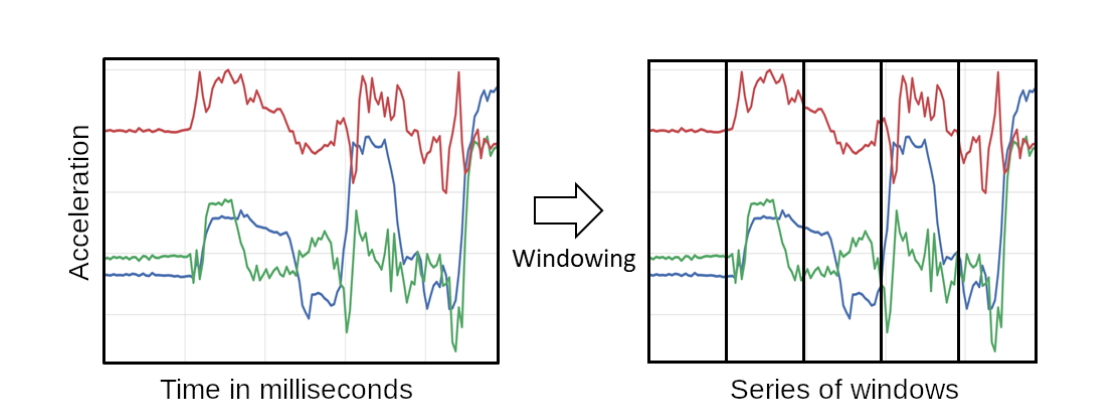
Figure 6. Windowing of inertial data. Windows have a length of 1s and an overlap of 50% or